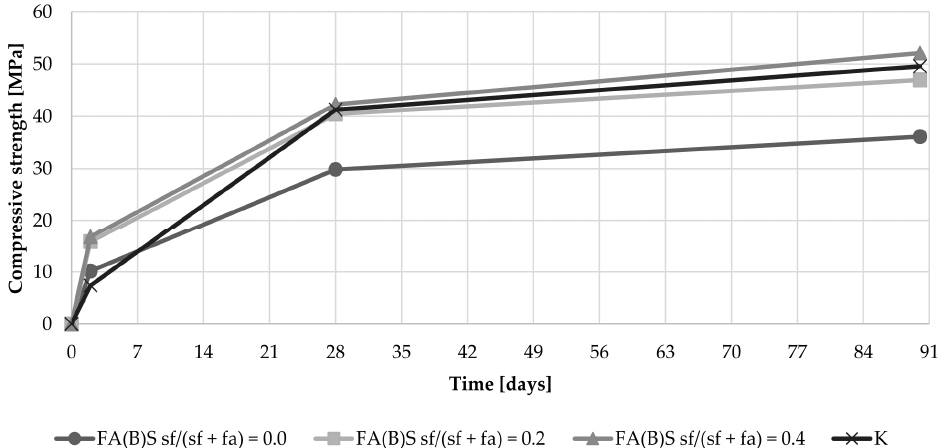
Figure 8. Compressive strength development of cement mortar with the addition of fly ash activated by sieving.